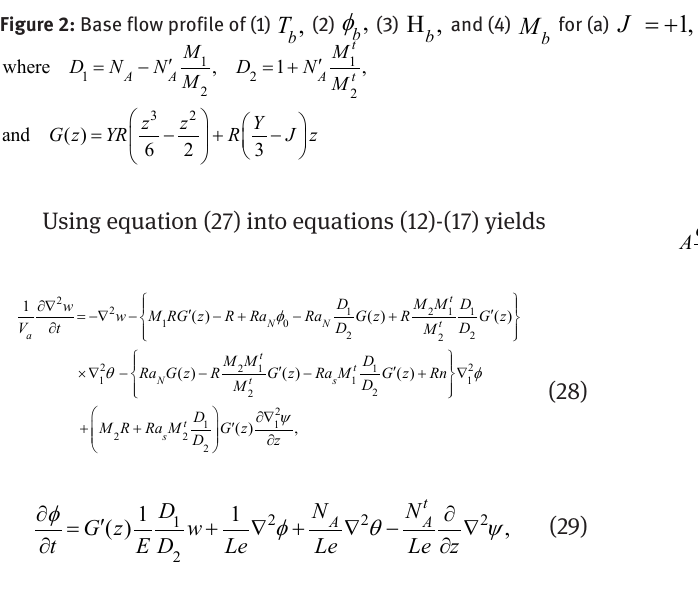
Figure 2: Base flow profile of (1) ,